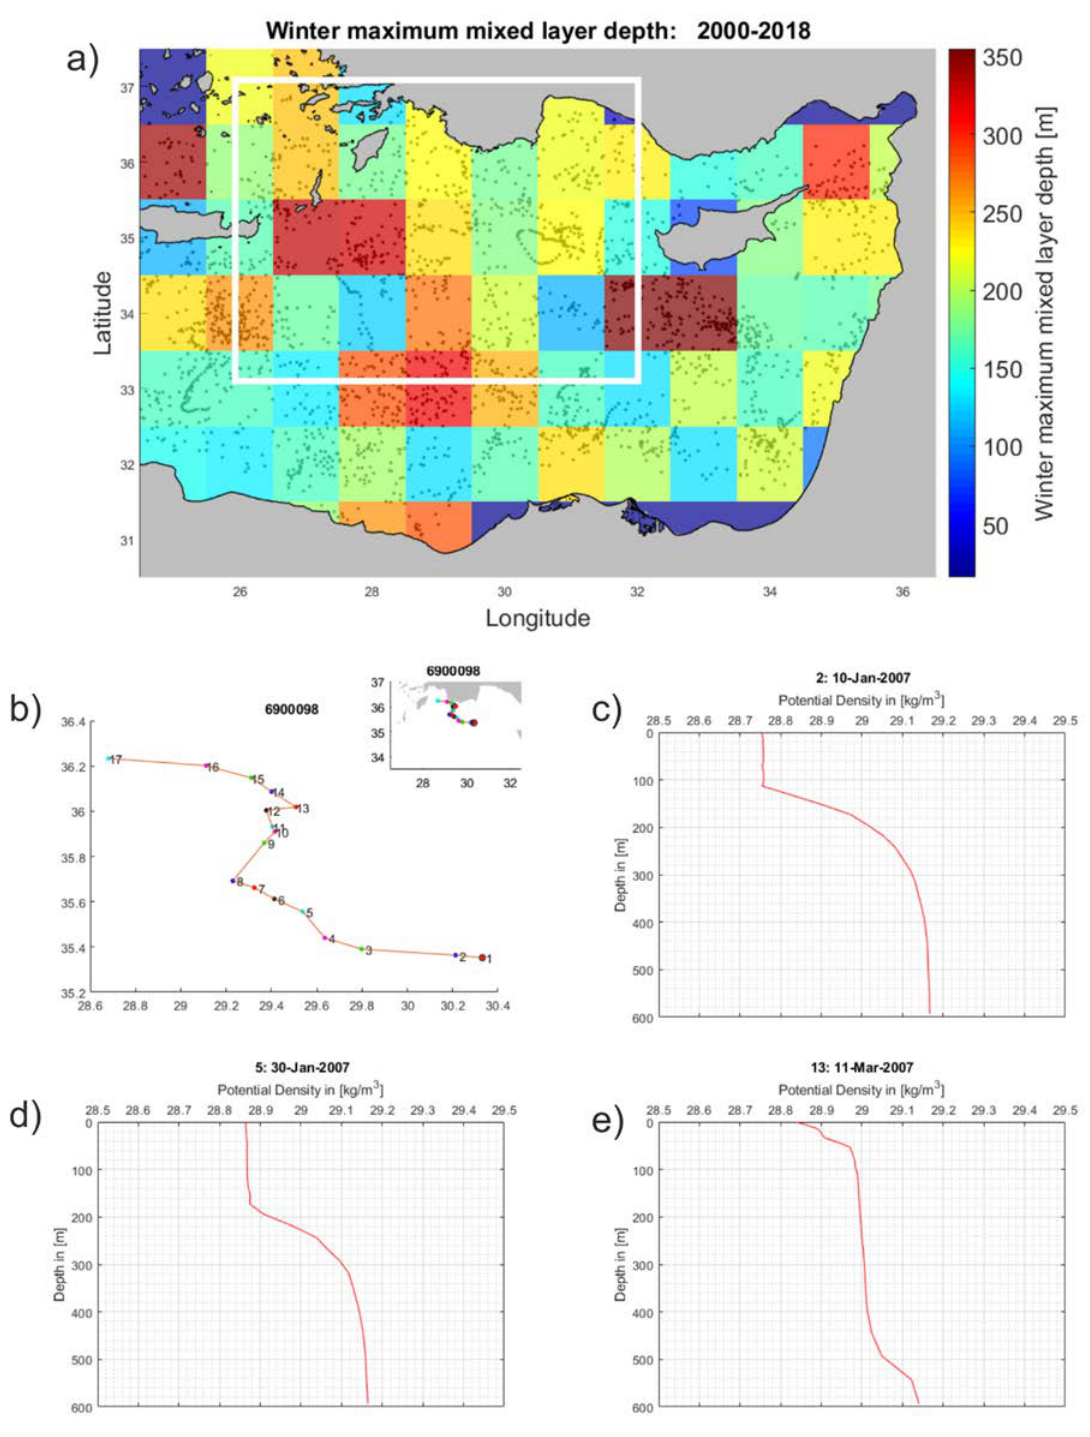
Figure 3. ( a ) Climatology of the winter maximum mixed layer depth (colors) and location of float profiles (grey dots) from 2000 to 2018. The white rectangle indicates the area of study, the NWLS. ( b ) Trajectory of the float WMO 6900098 during JFM 2007; the numbers along the trajectory show the locations of float profiles. Float potential density profiles at cycle 2 ( c ), 5 ( d ), and 13 ( e ). The SST and sea surface height (SSH) data were downloaded from Copernicus (marine.copernicus.eu). The interpolated SST product (SST_MED_SST_L4_NRT_OBSERVATIONS_010_004_c_V2) has a daily ◦ × ◦ temporal resolution and a spatial resolution of 0.04 0.04